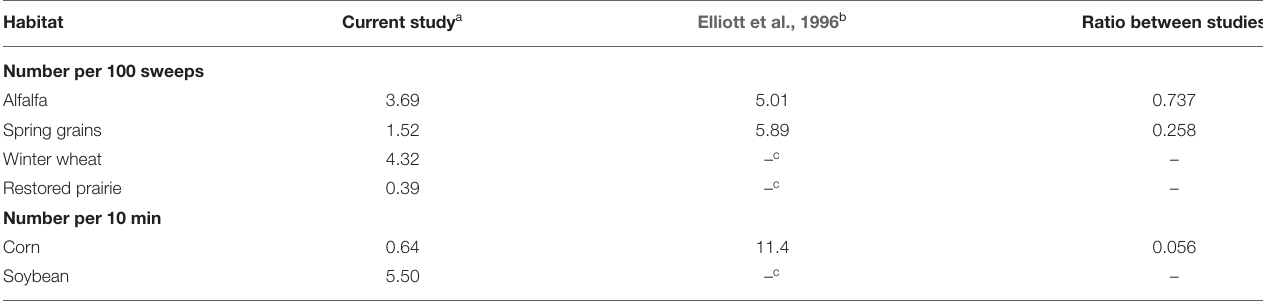
TABLE 5 | Sample rates of adult coccinellids among habitats in two studies from east-central South Dakota, USA. Habitat Current study a Elliott et al., 1996 b Ratio between